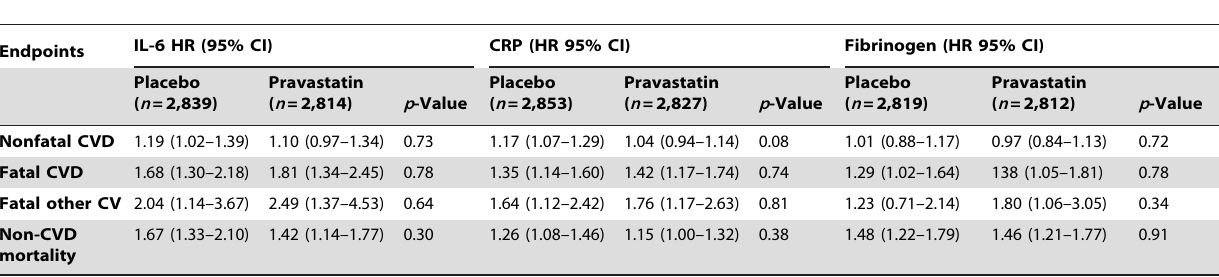
Table 2. Associations of IL-6, CRP, and fibrinogen (HR for 1-unit increase in log IL-6, log CRP, and fibrinogen) of experiencing one of four categories of events by baseline treatment